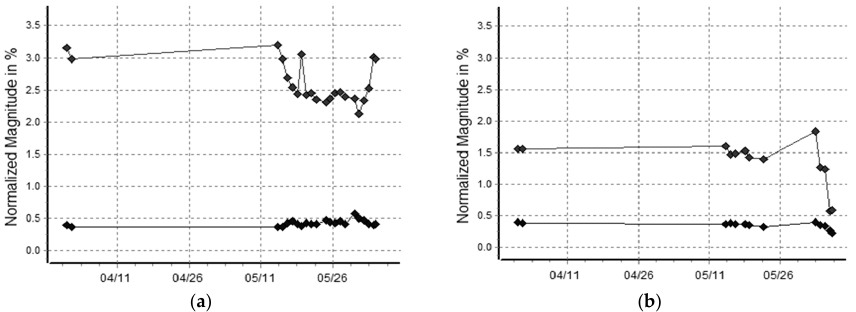
Figure 5. Trend of the Extended Park’s vector approach (EPVA) electrical unbalance of voltage (lower curve) and current (upper curve) signatures for GUs at Goiandira power plant: ( a ) GU#1; ( b ) GU#2. Table 1. Results of the two-sample t-test for the EPVA electrical unbalance at current signature. GU Number of Samples Mean Standard Deviation Standard Error of the Mean GU#1 117 2.535 0.329 0.030 GU#2 46 1.35 0.410 0.060 Estimated difference: 1.1842 Confidence interval of 95% for the difference: (1.0493; 1.3191) t-Test of the difference = 0 (vs not =): p-value = 0.000